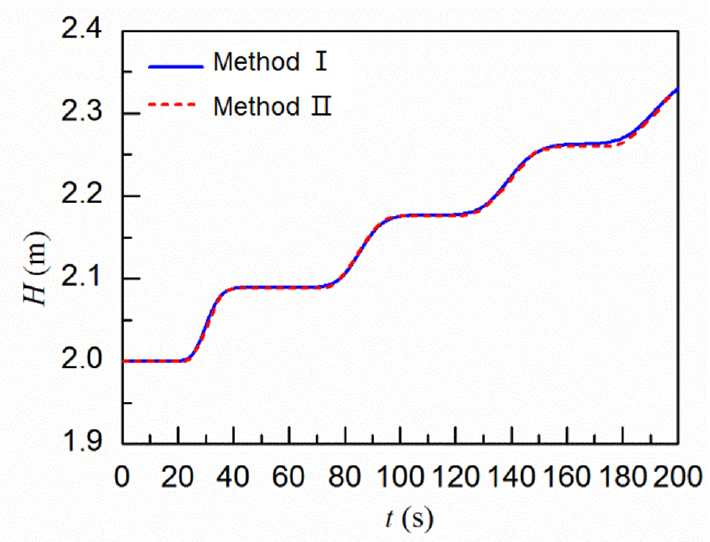
Figure 5. Comparison of the simulated results by the MOC-FVM coupling method and the 3D FVM.